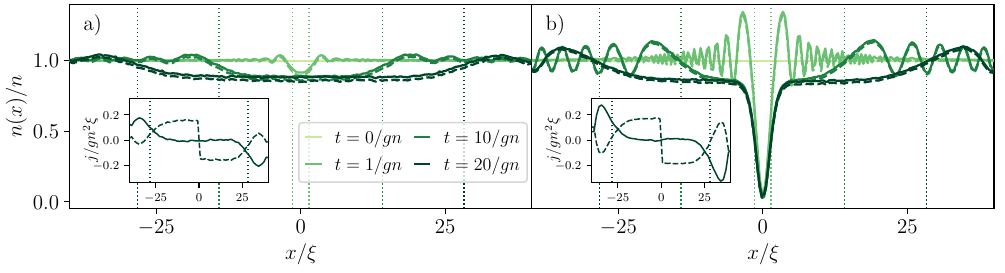
Figure 2: Snapshots of density close to a static noisy point contact in a) the linear- response phase σ = 0.2 gn ξ and b) in the Zeno phase σ = 8 gn ξ . Solid lines are total densities | φ ( x , t ) | 2 while dashed lines are the coherent ones | φ ( x , t ) | 2 . The density of incoherent particles is low. The insets show the coherent (dashed) and total (solid) particle current. The point contact scatters particles out of the coherent state, leading to a coherent current towards the noise contact and an incoherent counterflow, which exactly balances the coherent flow. The dotted vertical lines mark the size of the (cid:112) gn / m . Colors match the ‘sound’ cone, moving at the average speed of sound c = ones of the related density profiles evaluated at the same